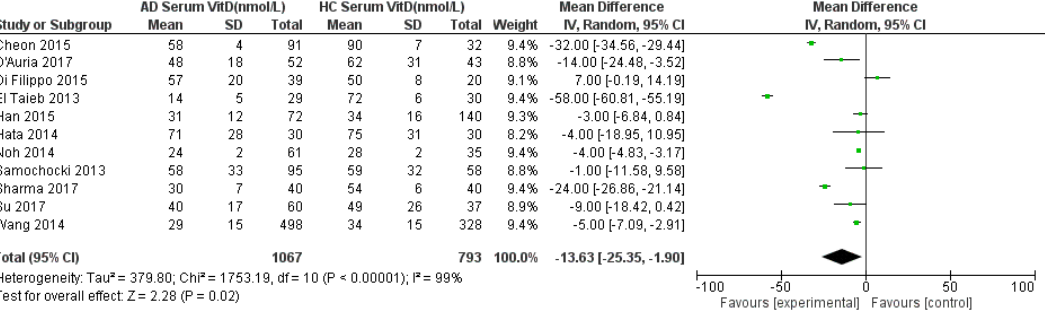
Figure 2. Forest Plot for meta-analysis of serum 25(OH)D levels in atopic dermatitis population compared with healthy controls (nmol/L). References: Cheon 2015 [27]. D’Auria 2017 [28]. Di Filippo